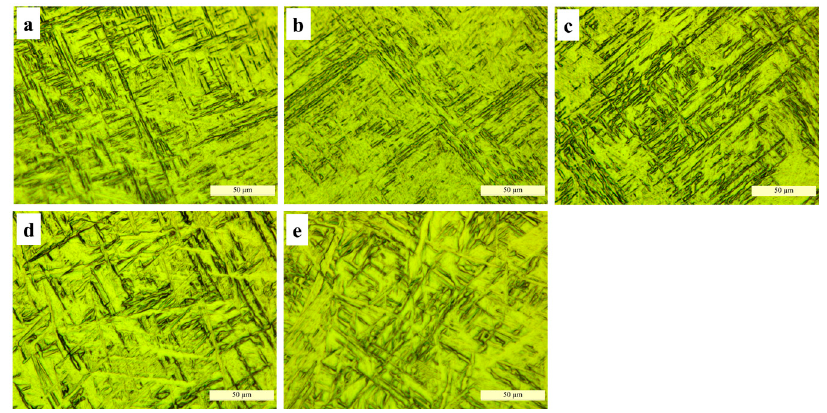
Figure 9. Microstructure of samples manufactured with WMP of ( a ) 7 mm; ( b ) 10 mm; ( c ) 14 mm; ( d ) 19 mm and ( e ) 22 mm.